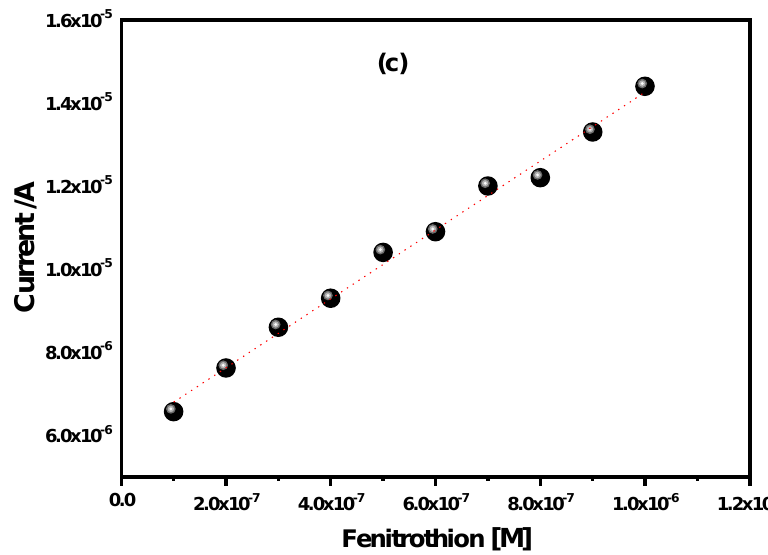
Figure 11. Effect of different concentration in the square wave voltammetric voltammograms on the peak current signal for fenitrothion ( a ), calibration plot for fenitrothion ( b ) and calibration plot for parathion ( c ) in a phosphate buffer (pH = 8.0) using cyclic voltammetry.